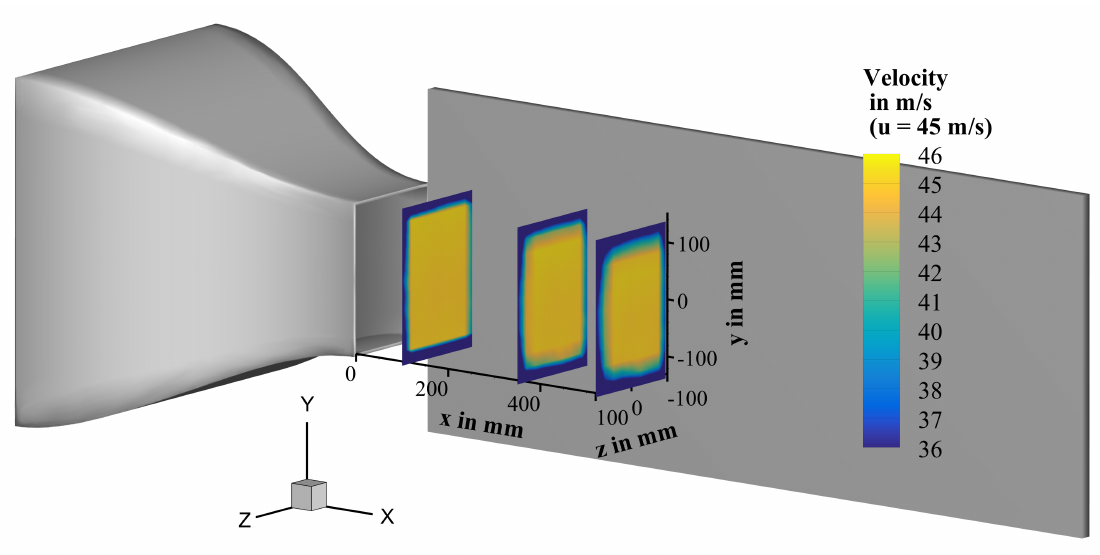
Figure 6. Velocity profile at 45ms − 1 with distances x = 100, 350 and 520mm from the nozzle outlet.